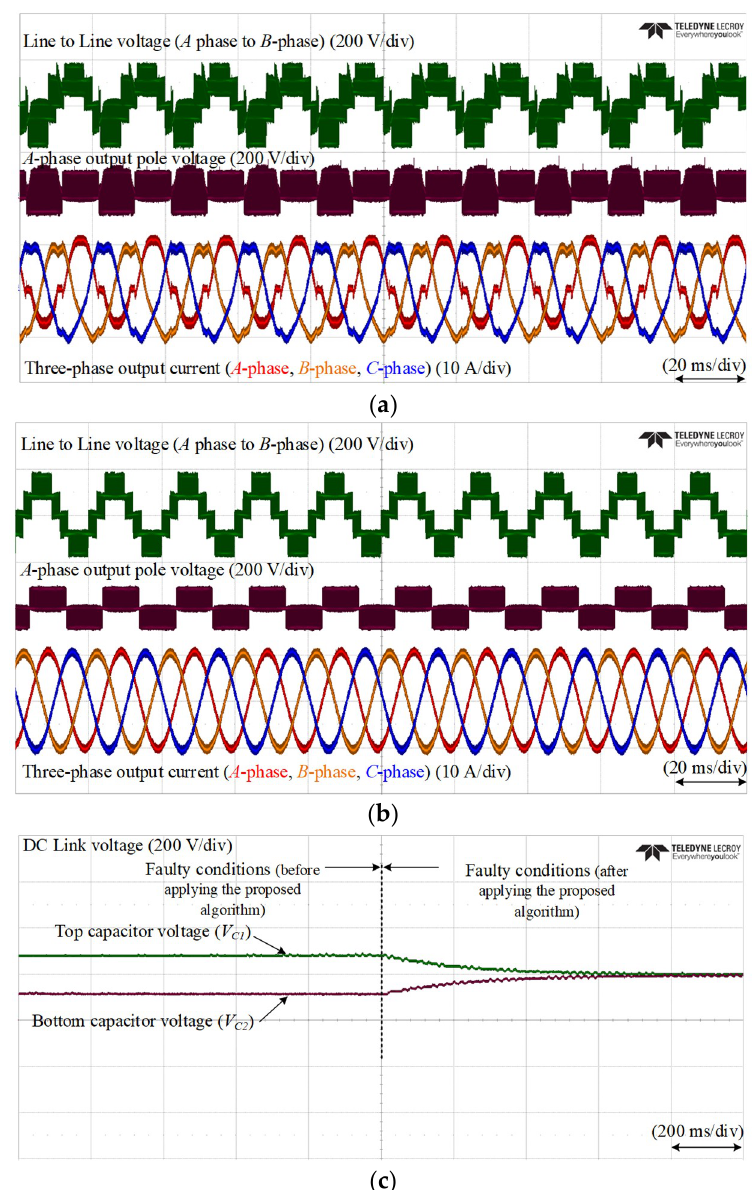
Figure 14. Experimental results for V ab , V an , and three-phase currents when an open-circuit failure occurs at S a2 /D a2 at ( a ) faulty conditions (before applying the proposed method), ( b ) faulty conditions (after applying the proposed method), and ( c ) top and bottom capacitors voltages before and after applying the proposed method.